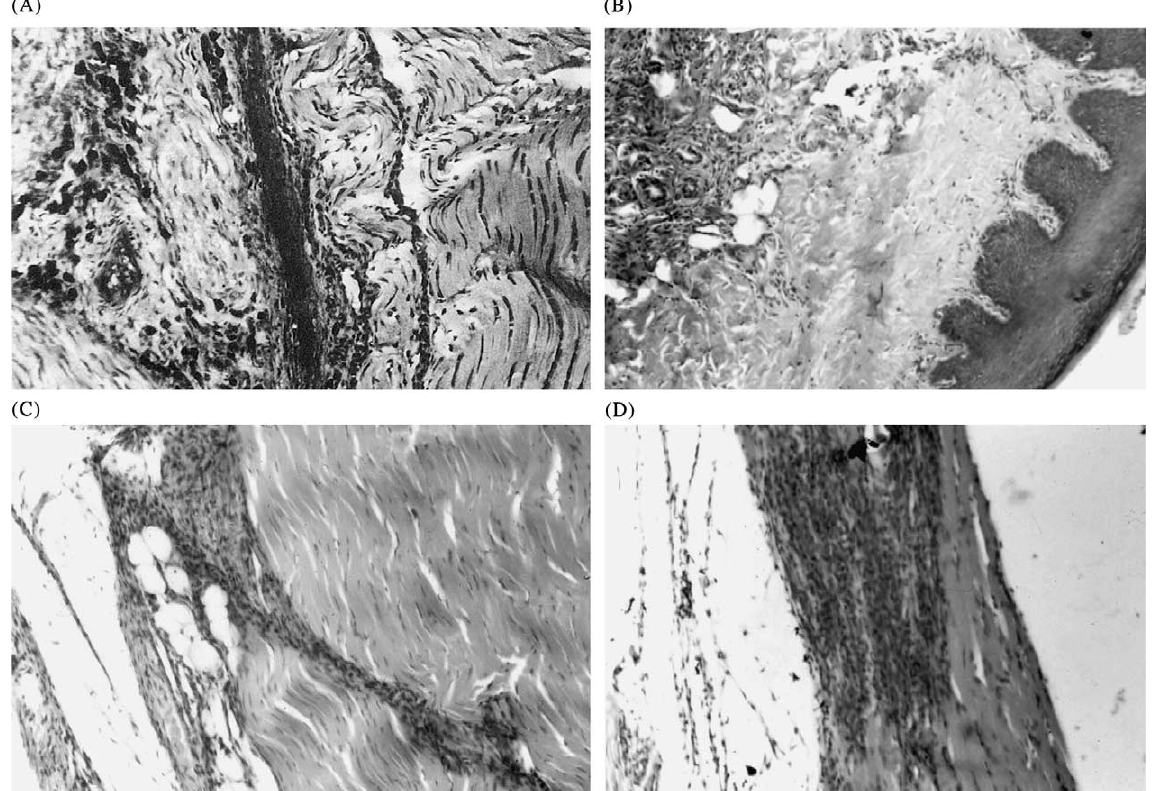
FIG. 3. Three days after tendon injury in the rat ( (cid:4) / 10, haematoxylin and eosin). (A) Control, no treatment: the subcutaneous tissue is edematous and is invaded by inflammatory cells that are mostly monocytes/macrophages and there are some darkly staining mast cells in close proximity to the tendon. Reproduced by kind permission from Martin Dunitz Ltd (1997). (B) L- NAME treatment: edema in the subcutaneous tissue that is heavily infiltrated by larger mononuclear cells with larger nuclei than those in control injuries. Greater numbers of mast cells are also seen. (C) L-NAME treatment: severe adherence of large numbers of mononuclear cells to tendon. This is not normally seen in control injuries. (D) L-NAME treatment: extraordinarily severe adherence of large numbers of mononuclear cells to muscle. Not apparent in any of the control injured